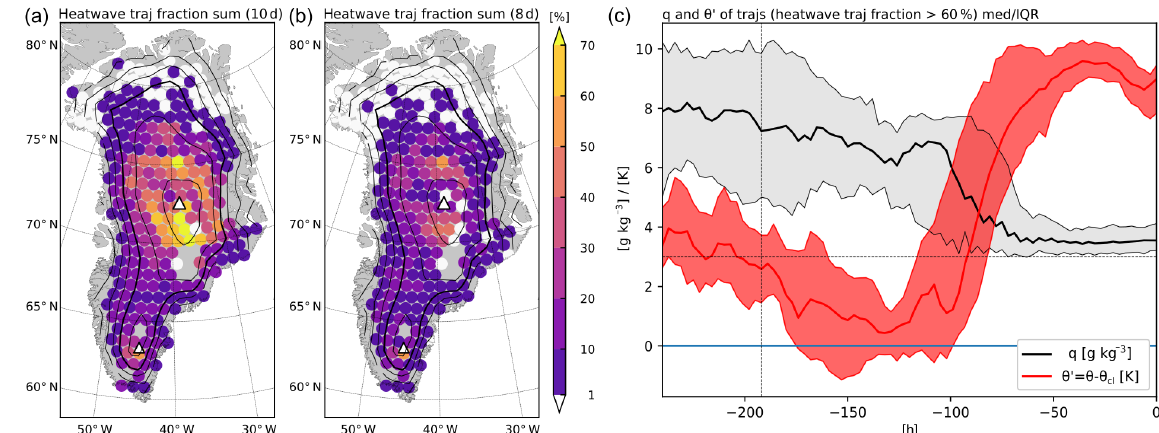
Figure 6. LFP maps of the trajectory fraction being associated with the North American heat wave (see text for details) for (a) the extended 10d or (b) 8d trajectories; panel (c) shows the median (solid line) and interquartile range (shading) of specific humidity q (grey) and θ (cid:48) with respect to θ cl (red) of heat wave trajectories ending at locations with a heat wave trajectory fraction > 60%. Dashed lines in (c) indicate t = − 192h and θ (cid:48) = +